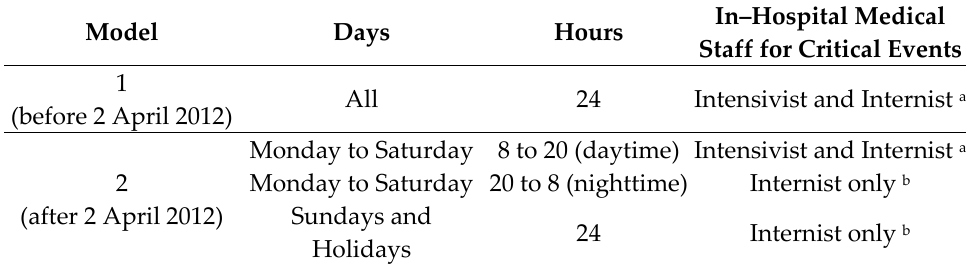
Figure 1. Timetable of the two models of in-hospital emergency